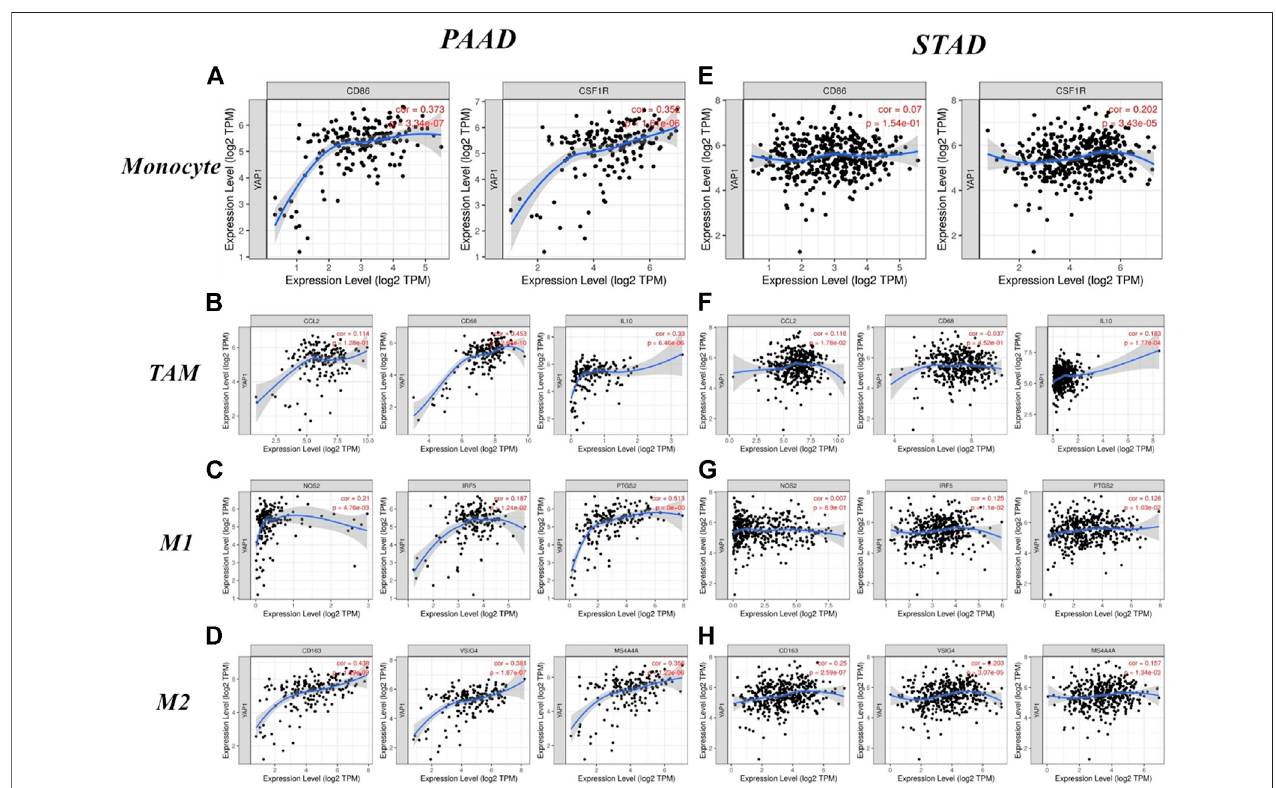
FIGURE 9 | Correlations between YAP1 expression and macrophage polarization in pancreatic adenocarcinoma (PAAD) and stomach adenocarcinoma (STAD). Markers include CD86 and CSF1R for monocytes; CCL2, CD68, and IL10 for tumor-associated macrophages (TAMs); NOS2, IRF5, and PTGS2 for M1 macrophages; and CD163, VSIG4, and MS4A4A for M2 macrophages.